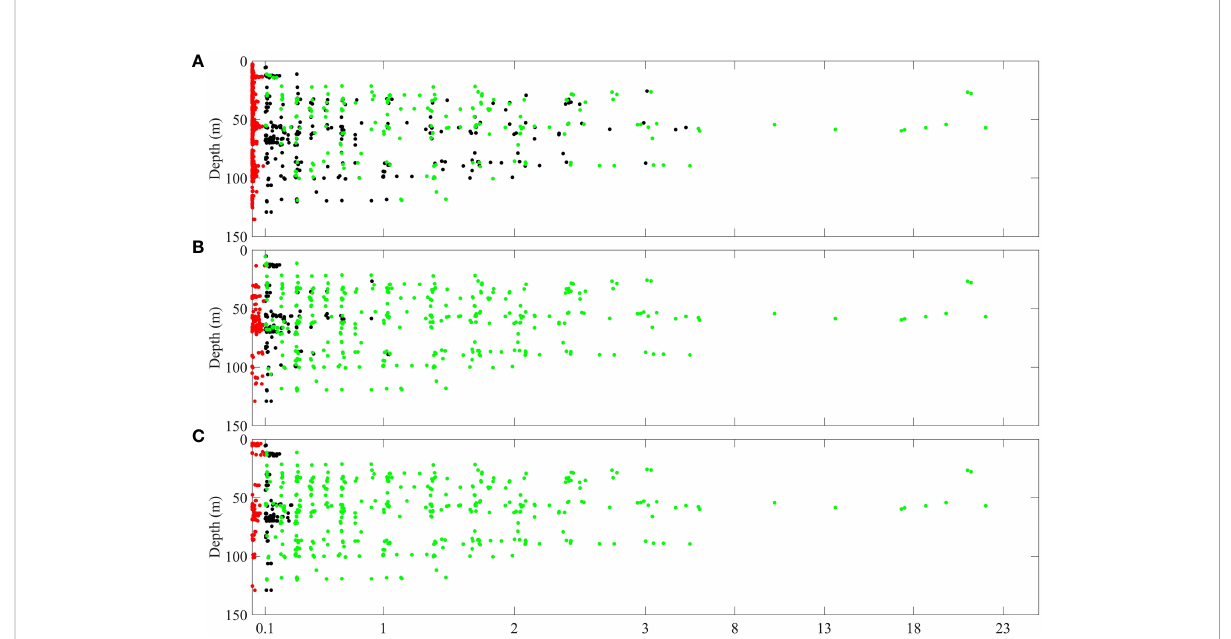
FIGURE 10 The outliers detected by the three methods in 20 cases. (A-C) are the distribution of outliers detected by the WE method, the MFMD method and the CSF method respectively. Green dots, black dots and red dots are real outliers, missed real outliers, and misjudged good data,